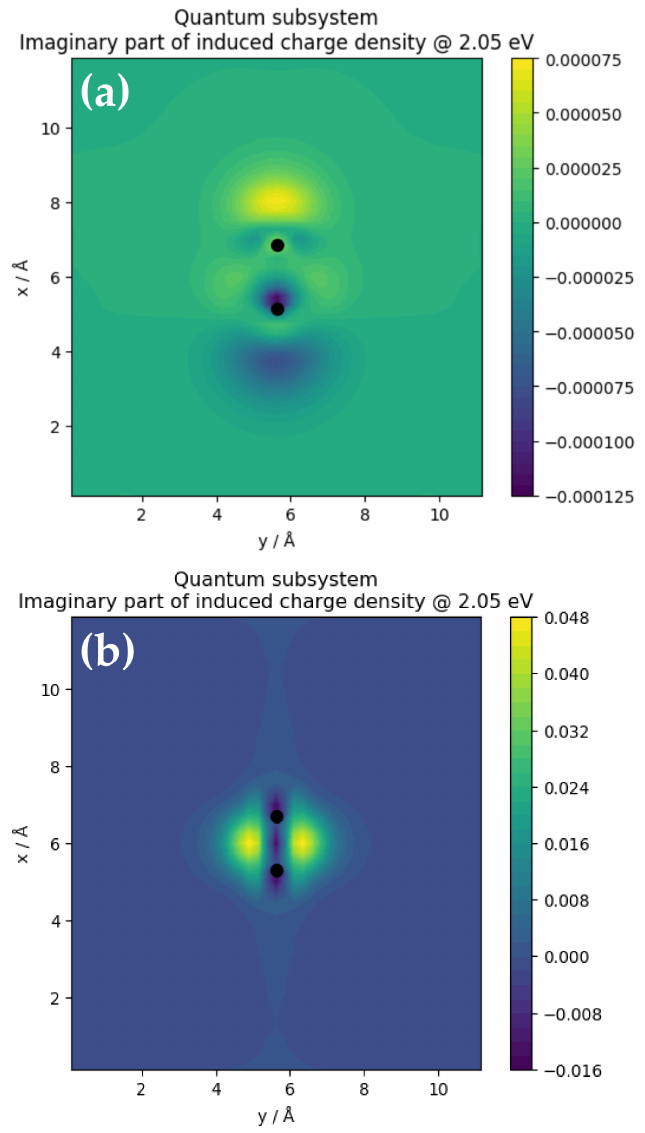
Figure 6. The imaginary part of the induced volume charge density in the quantum subsystems Ta–As ( a ) and C–C ( b ) dimers. The color bars denote the induced volume charge density in Coulombs/Å 3